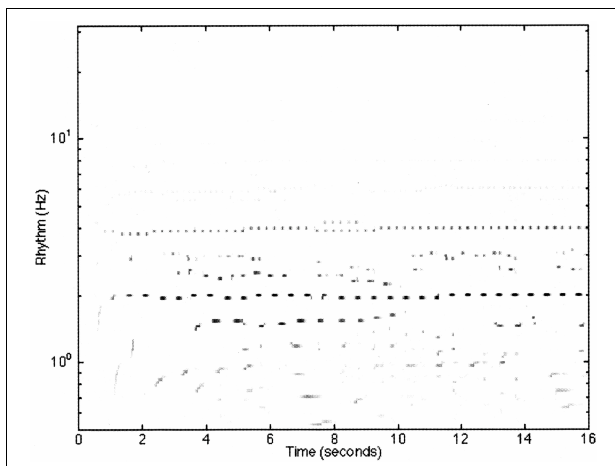
FIGURE 6 | A reproduction of Figure 12 from Todd et al. (1999) illustrating the model response to the first 4 bars of the Fugue No. 2, Bk I of the Well-Tempered Clavier by JS Bach. The sampling rate of the input was at 22,050Hz with 8 bit resolution. Thirty-two cochlear channels were used ranging from 30Hz to 8000kHz. All cortical filters ran at a sampling rate of 1000Hz. The frequencies of the cortical band-pass filters ranged from 32 to 0.5Hz spaced at 24 per octave. The feed-forward model had a preferred rate of